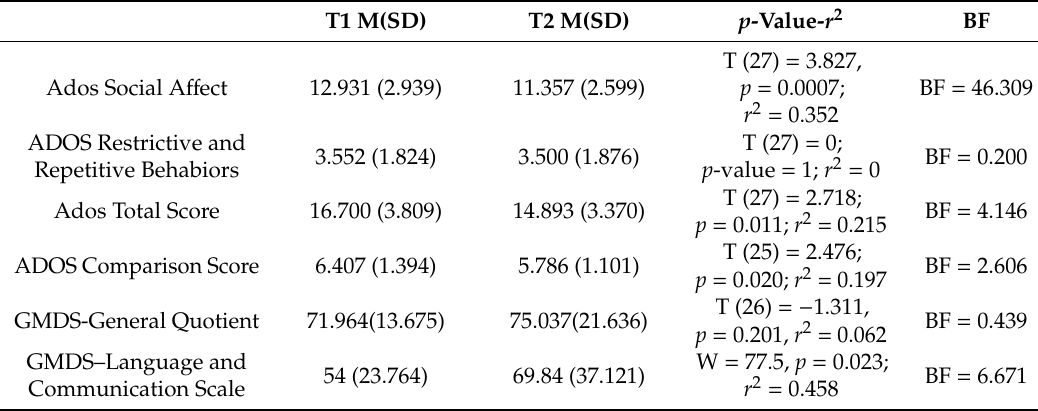
Table 2. Developmental child’s outcomes before and after